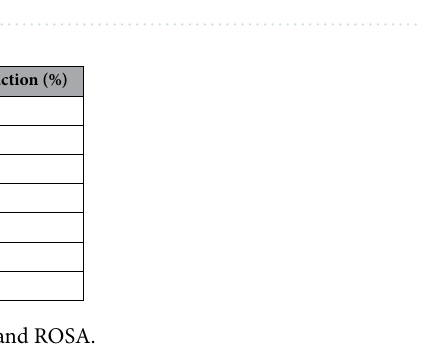
Figure 3. SEC–MALS analysis. SEC–MALS profiles of ( A ) ROWA and ( B ) ROSA. The blue lines and the black lines represent the normalised intensity of UV absorbance ( A 280nm ) and the molecular mass of the protein oligomers for each peak, respectively.